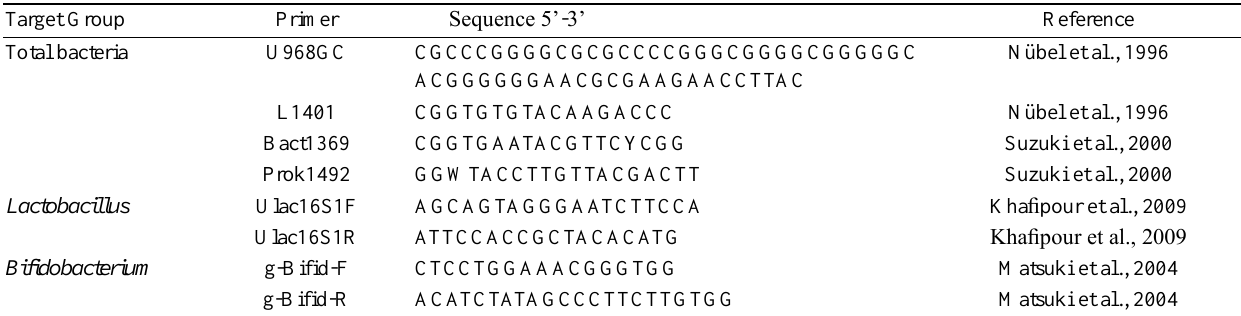
Table 1. List of primers used in this